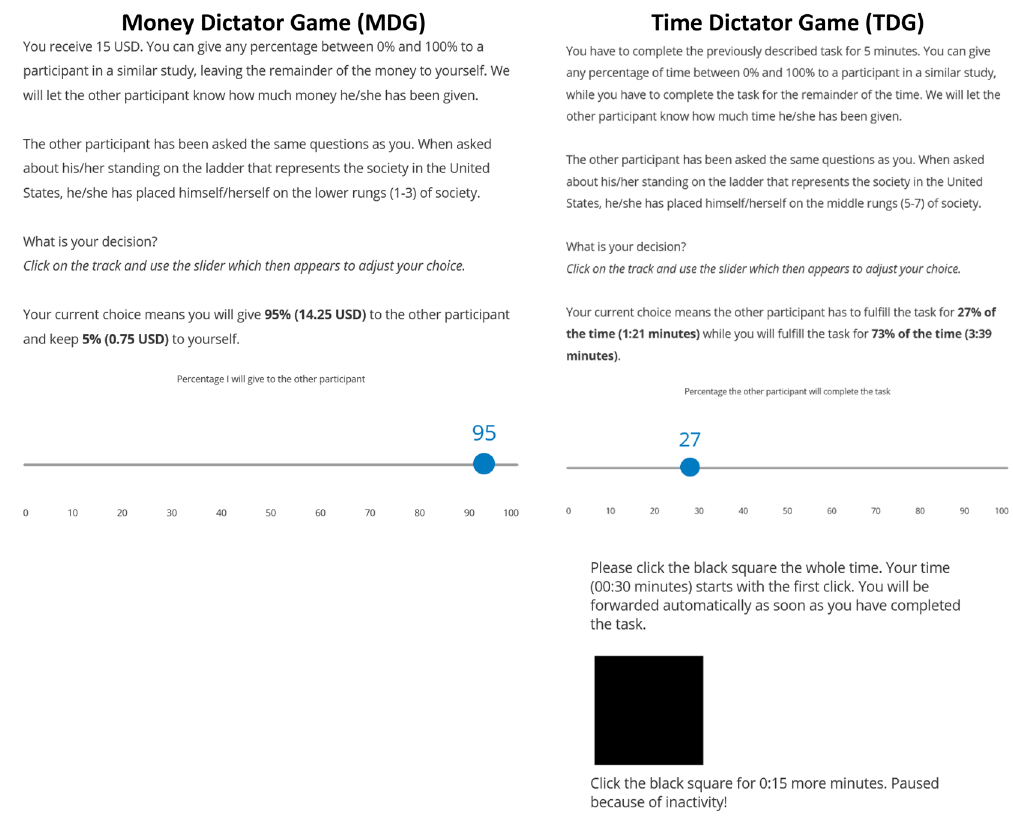
Figure 3. Experimental setups of the MDG (left) and TDG (right) with status information on recipients. The measure of the TDG was reverse coded in the analysis for higher values to express more